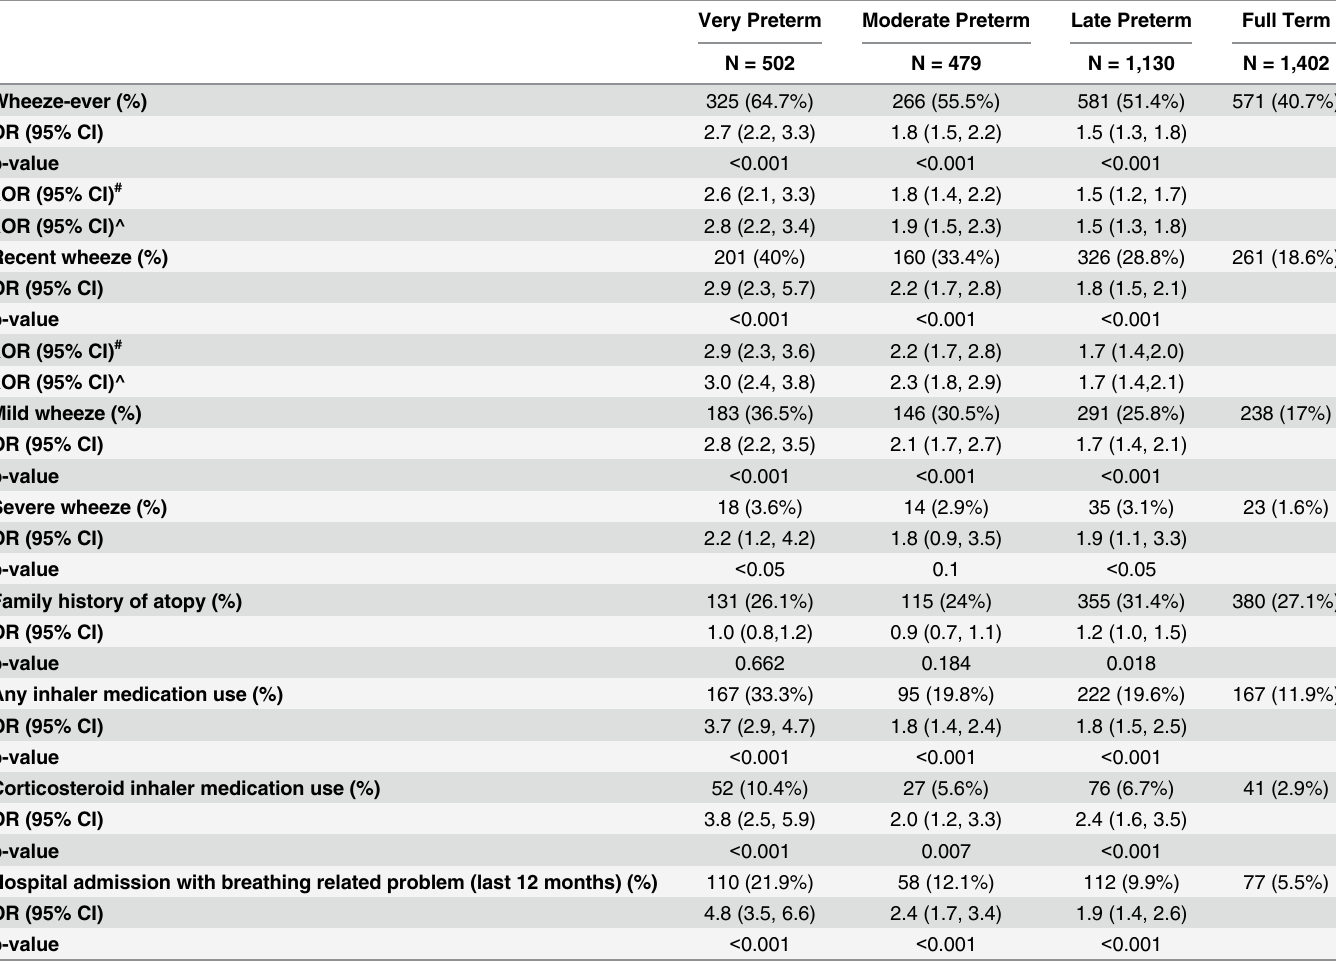
Table 3. Childhood wheezing, family history, inhaler use and hospital admissions for all children less than 5 years-of-age compared by gestational age (unadjusted